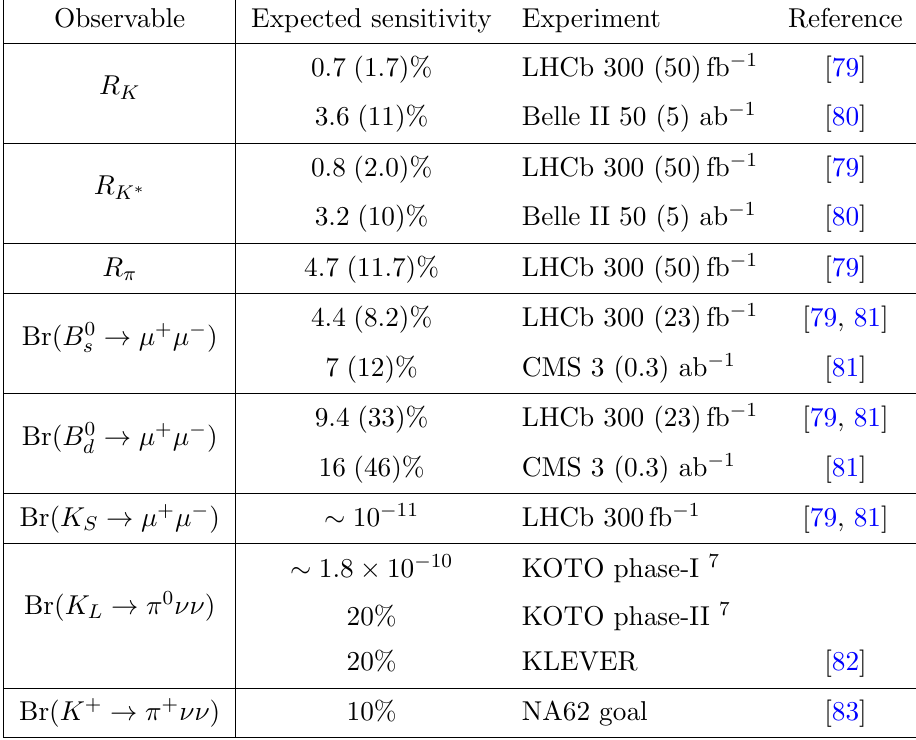
Table 7 . Future prospects for the precision reach in various (cid:13)avor observables. The expected sensitivity in percent are quoted with respect to the Standard Model